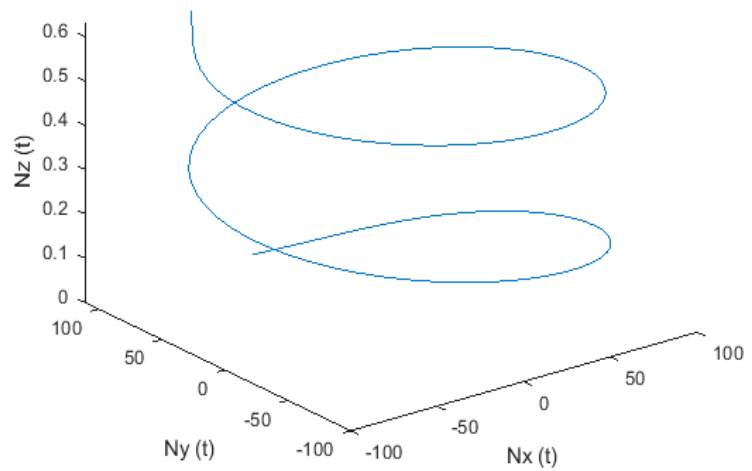
Figure 1. Numerical solutions of the Bloch equation with parameters: 𝛼 = 𝛽 = 𝛾 = 1 , 𝑤 (cid:2868) = 12 , 𝑇 (cid:2869) = 1 , 𝑇 (cid:2870) = 20 , 𝑎 = 1, 𝑏 = 1 .